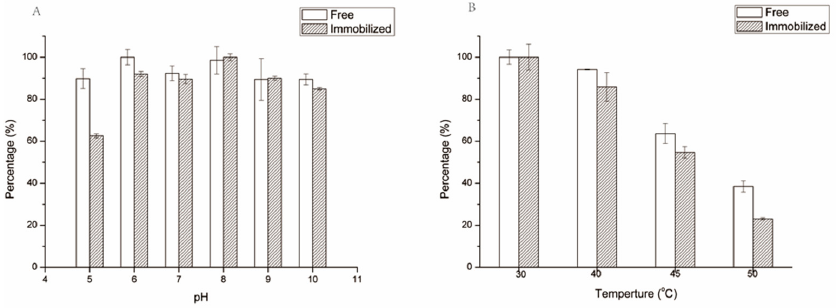
Figure 4. pH ( A ) and thermo- ( B ) stability of free and immobilized SrtA. Experiments were performed as described in Section 3.5.